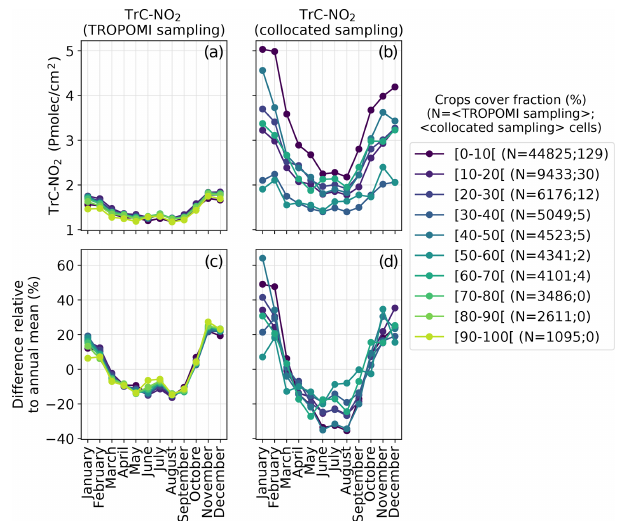
Figure 10. Mean monthly profiles (a, b) and differences relative to annual mean (c, d) , for different levels of crops cover fraction, con- sidering the TROPOMI TrC-NO 2 full dataset (a, c) and TROPOMI TrC-NO 2 collocated with surface stations (b, d) . The collocation of TROPOMI-based and surface-based observations is here performed both spatially and temporally (on a daily basis); the corresponding numbers of cells (averaged over the different months of the year) are indicated in the legend. Crops cover fractions are here binned in bins of